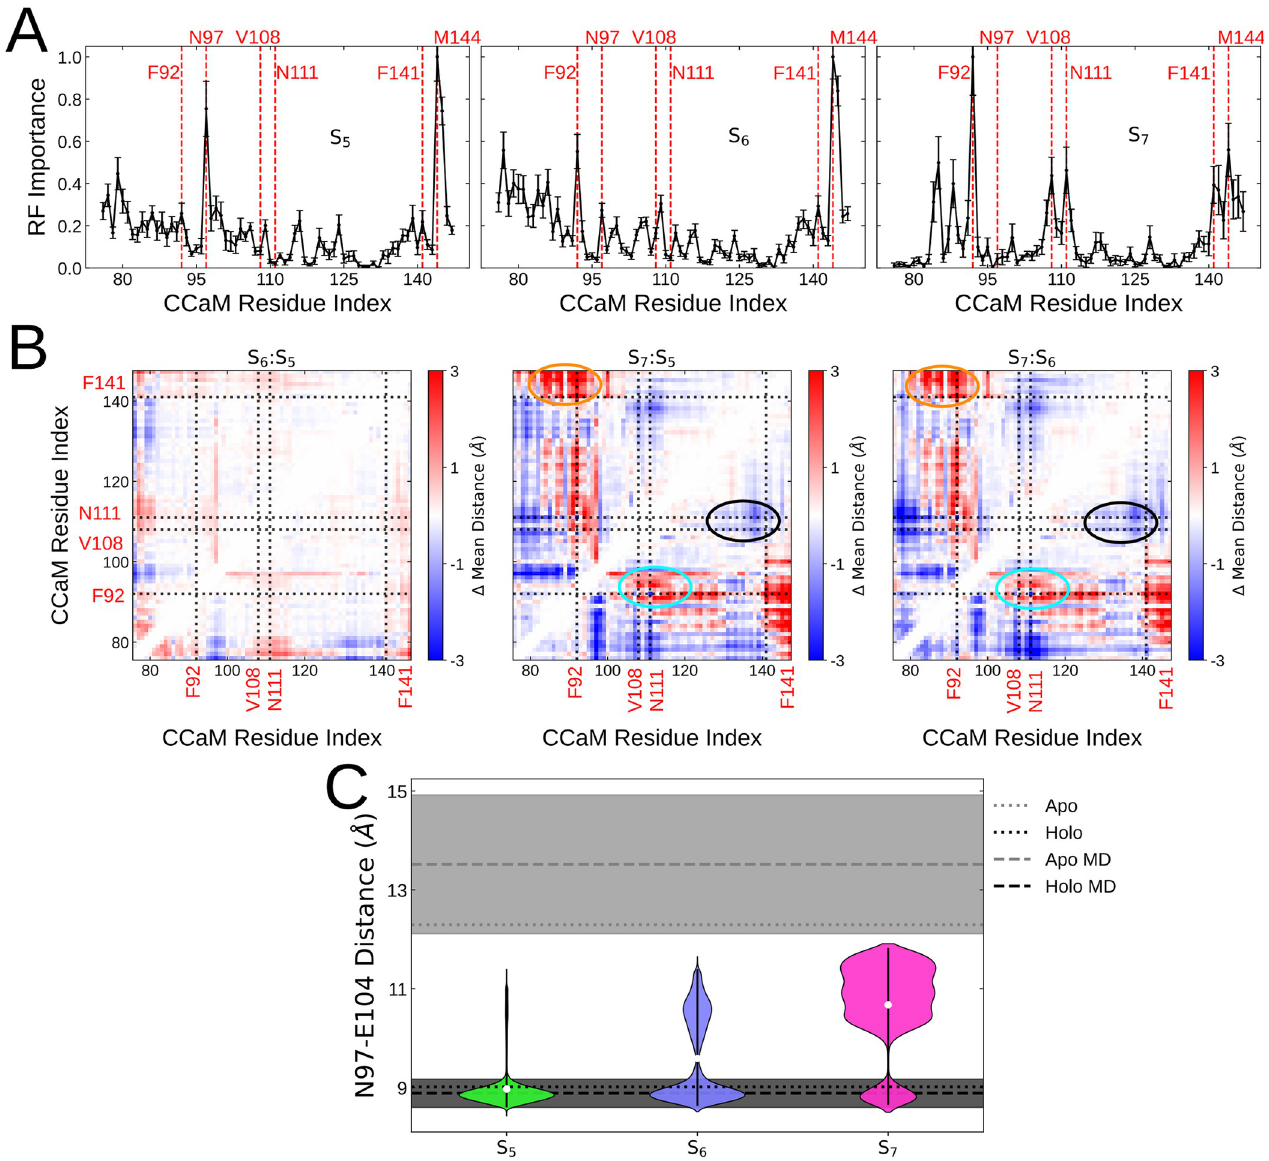
Fig 4. (A) The per-residue importance in discerning the S 5 , S 6 and S 7 macrostates calculated using the supervised Random Forest method. Plots represent the mean importance values calculated from five-fold cross-validation and the standard deviations are plotted as error bars. Physiologically important residues and those with high importance values are illustrated using red dotted lines. (B) Relative C-CaM inter-residue distances compared between the S 5 , S 6 and S 7 macrostates. The important F92, V108, N111 and F141 residues identified by the Random Forest method are illustrated as dotted lines. The increased distance between the F92-F141 and F92-V108 residue pairs in S 7 are highlighted as orange and cyan circles respectively. The decreased distance between the V108-F141 residues in S 7 is highlighted with a black circle/ (C) Distance between center-of-mass of the N97 and E104 residues making up the Ca 2+ binding site within the S 5 , S 6 and S 7 macrostates. Each violinplot spans the 5th and 95th percentile of distances and densities are weighted by the Markov state model probabilities. The median value for each macrostate is represented as a white dot. The inter-residue distances calculated from apo- (PDB: 1CFD [9]) and holo- (PDB: 1CLL [8]) calmodulin structures are shown as grey and black dotted lines respectively. The mean inter-residue distances within MD simulations [5] of apo- and holo- CaM are shown as grey and black dashed lines respectively. The standard-deviations of the residue distances within the MD simulations are shown as a shaded area.